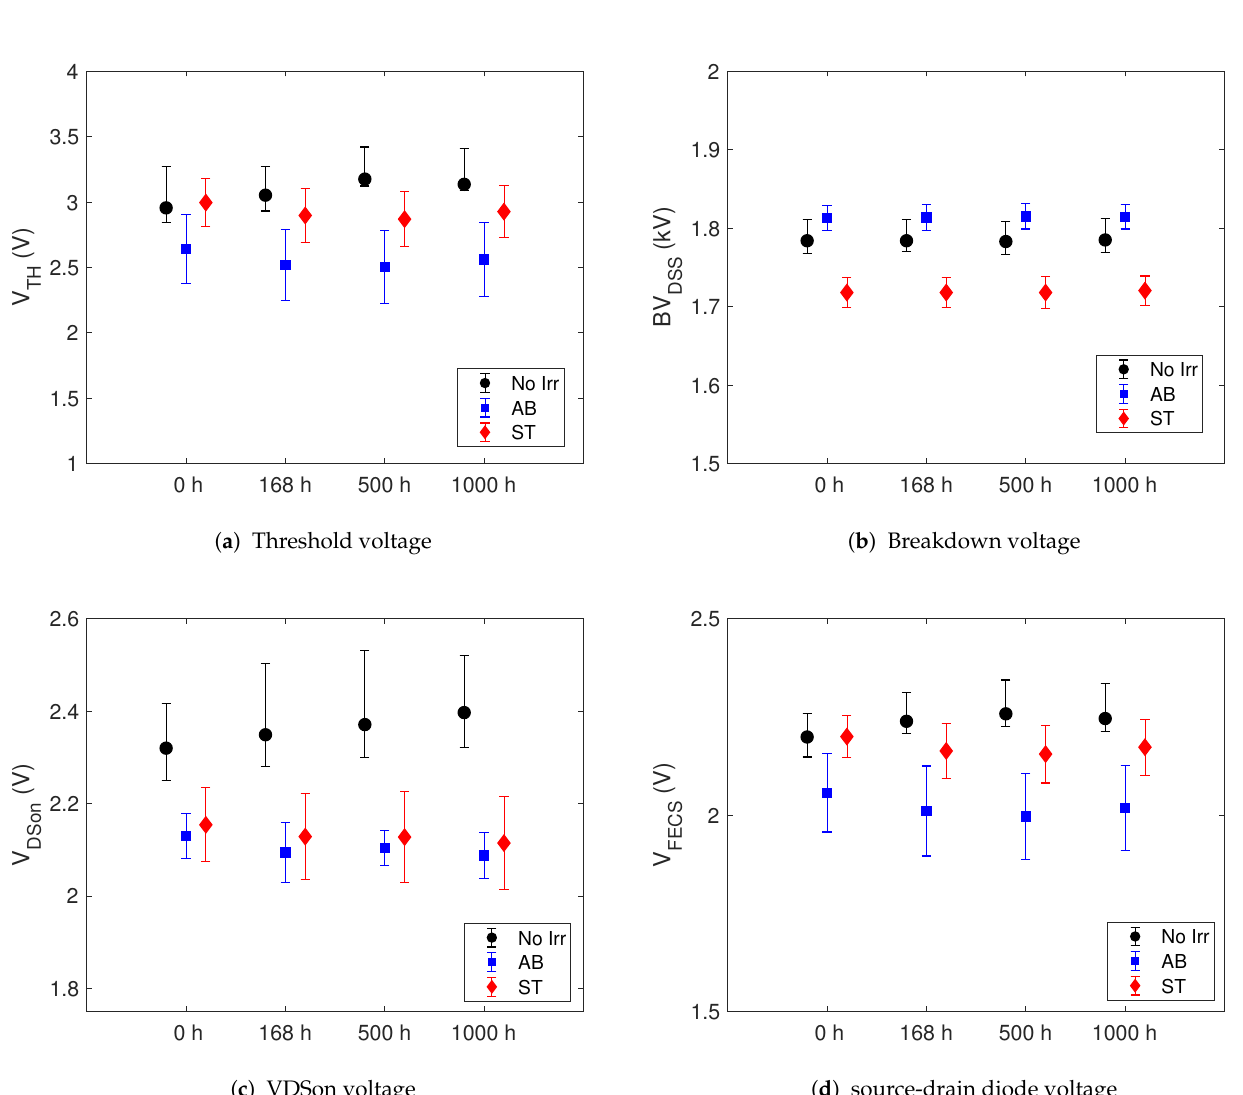
Figure 4. Shift of the median of some electrical parameters during HTGB2 stress of GEN3 SiC MOSFETs. The error bars indicate the minimum and maximum